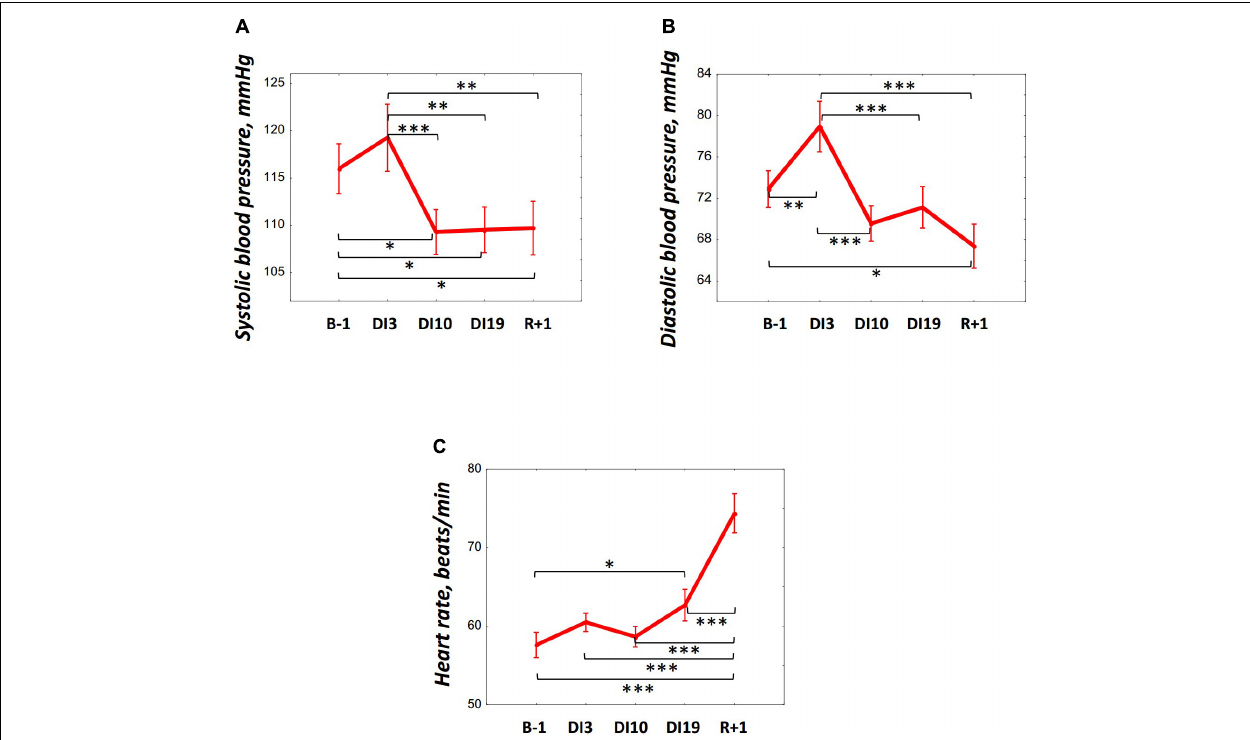
FIGURE 4 | Changes in the systolic blood pressure (A) , diastolic blood pressure (B) , and heart rate (C) during 21-day Dry Immersion and recovery. B-1, the day before dry immersion; DI3, DI10, and DI19, on the 3rd, 10th, and 19th days of dry immersion, respectively; R + 1, 1 day after the end of dry immersion. Intersession differences were examined using the post hoc Fisher LSD test. ∗ , ∗∗ , ∗∗∗ represent significance p < 0.05, p < 0.01, p < 0.001, respectively.